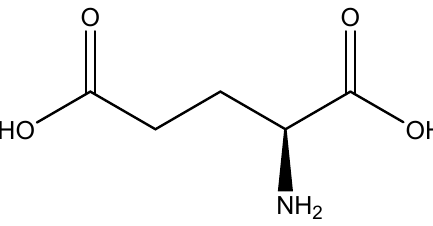
Figure 21. Structural illustration of L -glutamic acid.